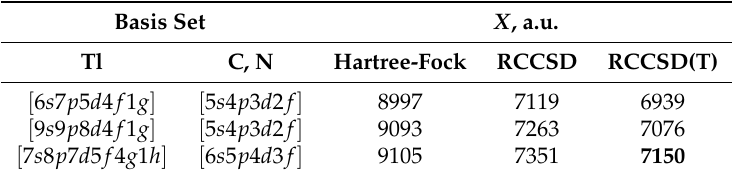
Table 3. Calculated values of the X parameter for TlCN. The recommended estimate is given in boldface. Basis Set X , a.u. Tl C, N